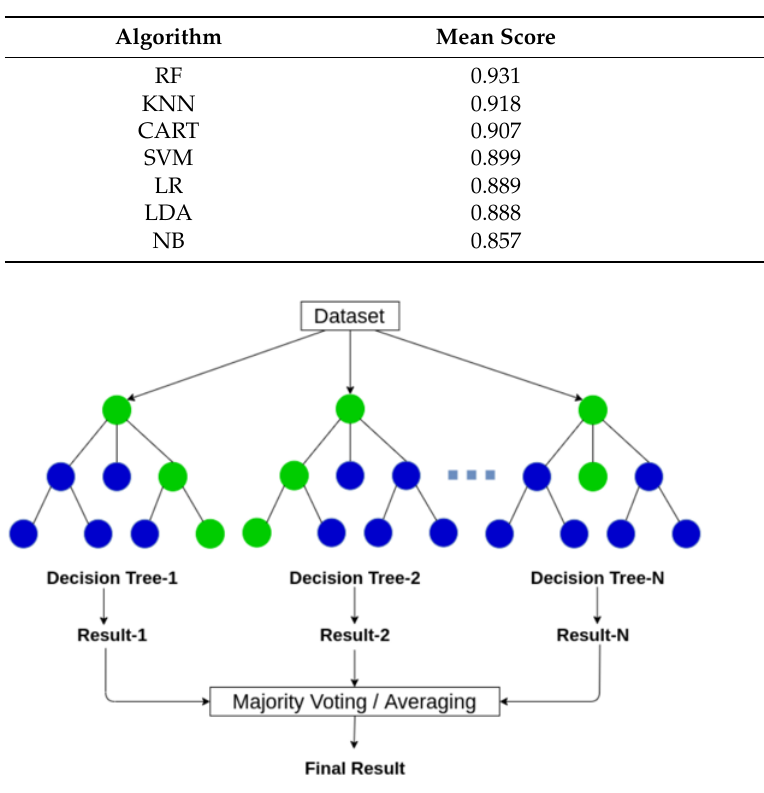
Table 2. Performance validation for ML algorithms.